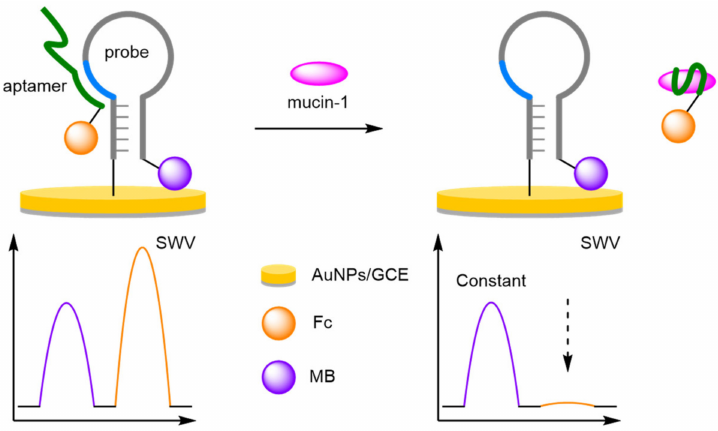
Figure 5. Schematic representation of an aptamer-based biosensor for the detection of